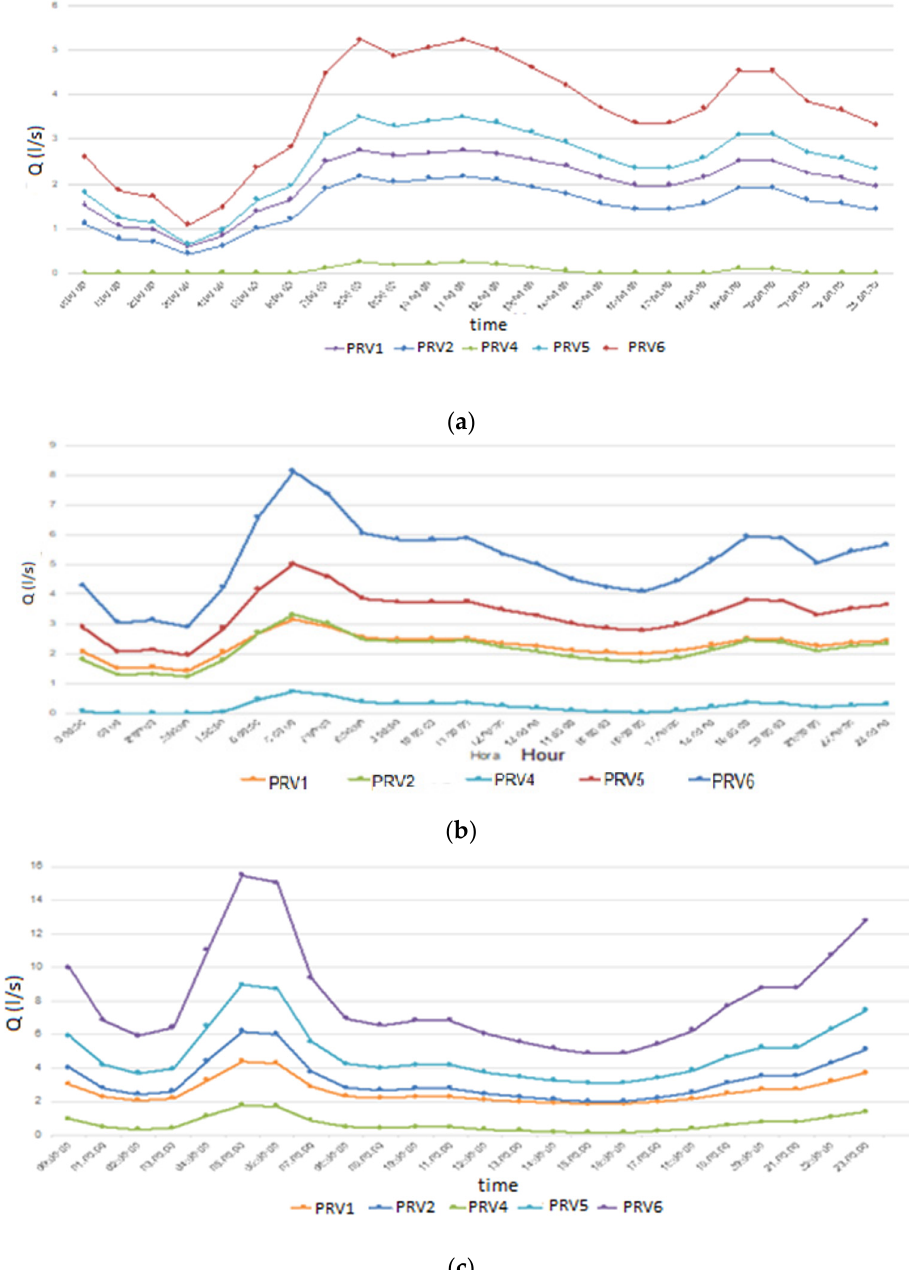
Figure 11. Flow rates within PRVs for different demand consumptions: ( a ) normal consumption; ( b ) high; ( c ) very high.